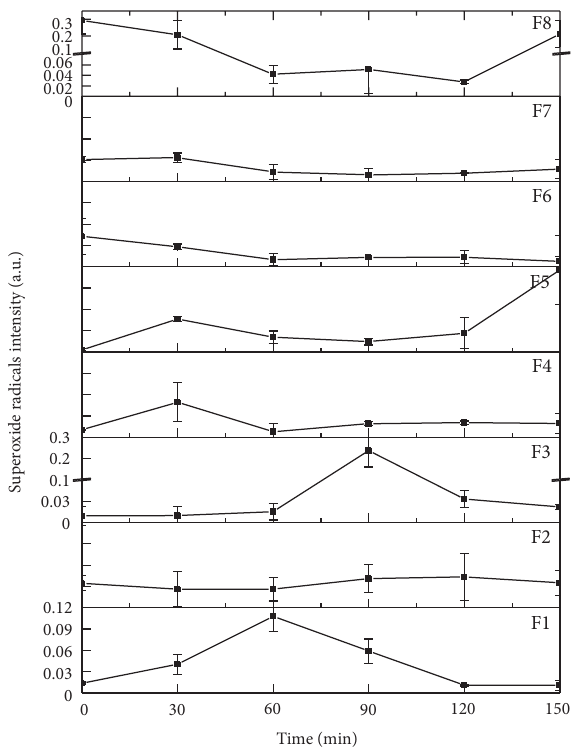
Figure 4: Superoxide radicals intensities during photoactivity assays ( TiO 2 / UV ) employing 2 3 factorial experimental design.